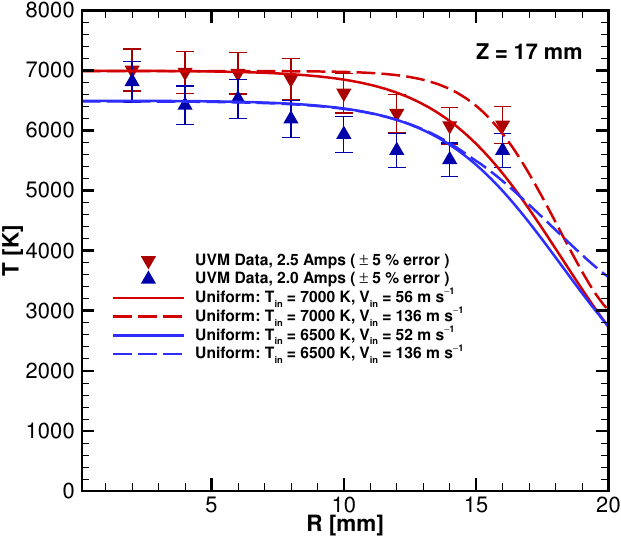
Figure 8. Plasma temperature measurements and simulated values at Z = 17 mm downstream of the torch